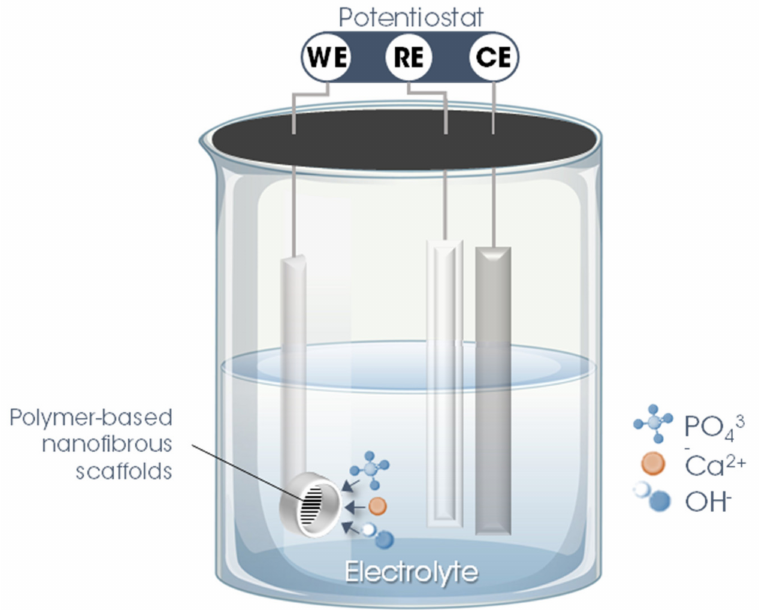
Figure 3. Schematic illustration of the hydroxyapatite electrodeposition process on the surface of electrospun polymer nanofibers. Legend: WE = working electrode; CE = counter electrode; RE = reference